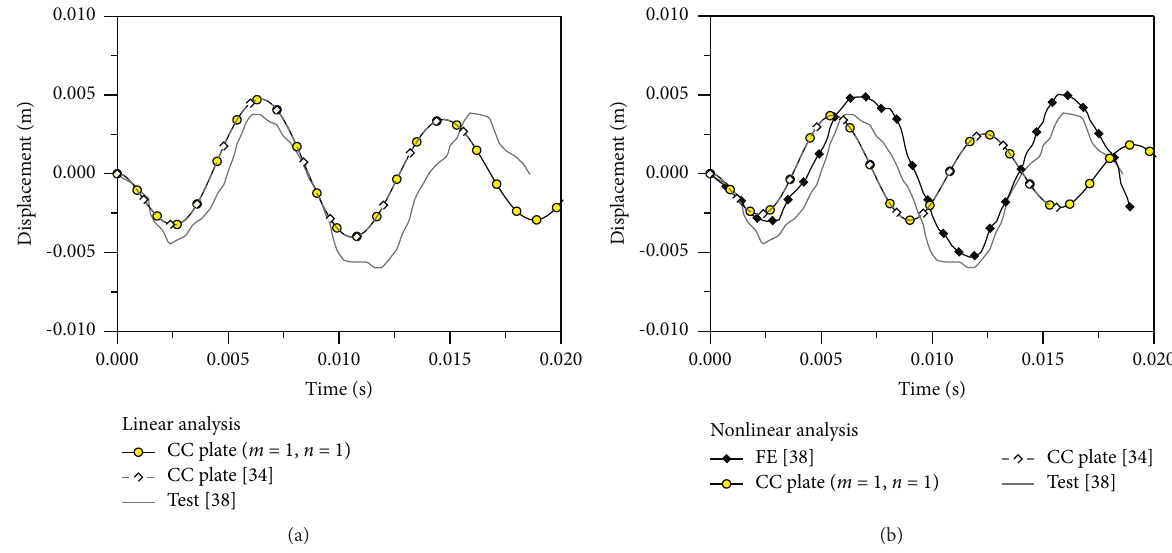
Figure 8: Out-of-plane displacement for a square steel plate under field blast loads, as obtained from the presently developed SDOF model and from literature [33, 38]. In evidence, the results are given by the (a) linear and (b) nonlinear solutions for the CC boundary condition.